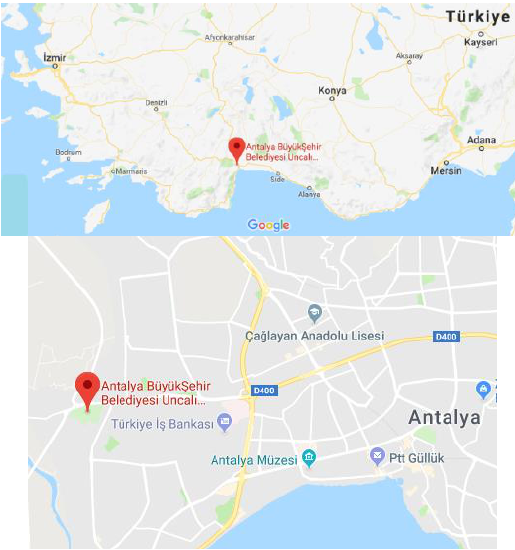
Figure 2. A map showing the location of the Uncali Cemetery (source: Google maps)